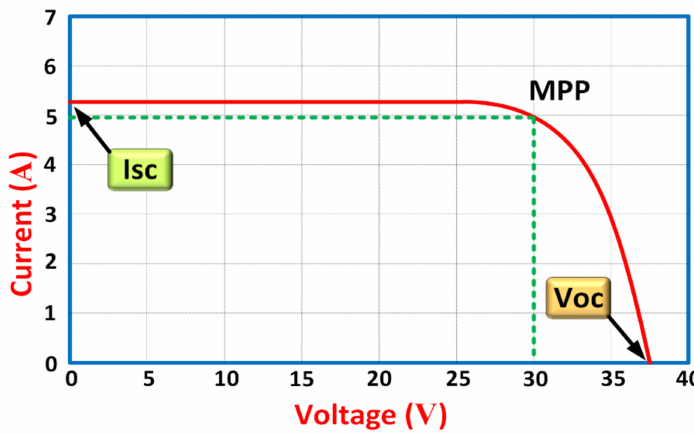
Figure 7. The current I– voltage V characteristics of a PV module.